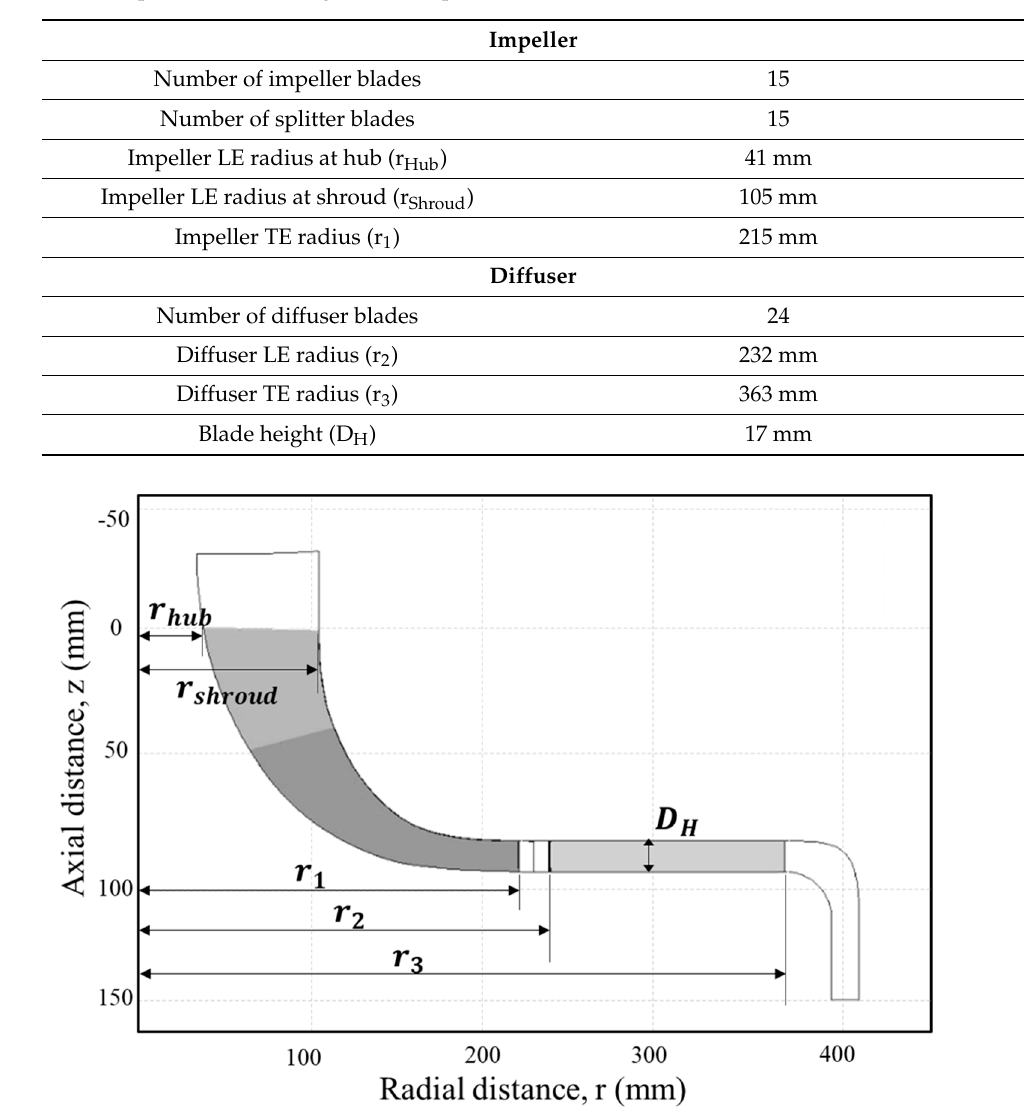
Figure 1. Specification of the geometrical dimensions.